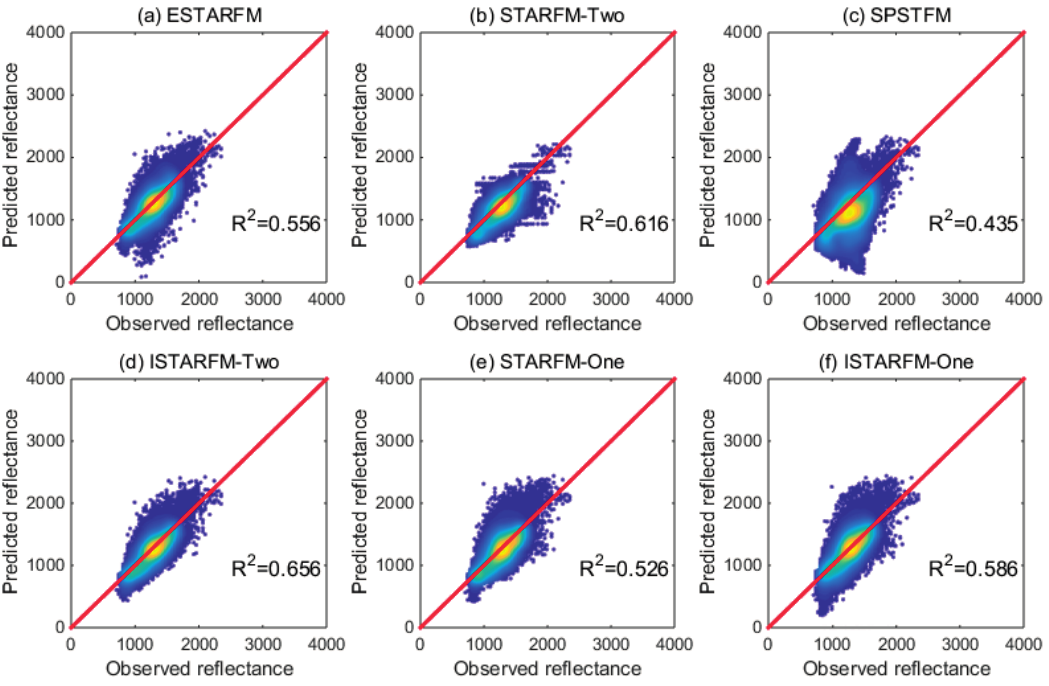
Figure 8. Comparison of the observed and predicted reflectance on 29 November 2004 for the red band (B3) from each blending model ( a – f ) using 1-to-1 fitting line at the